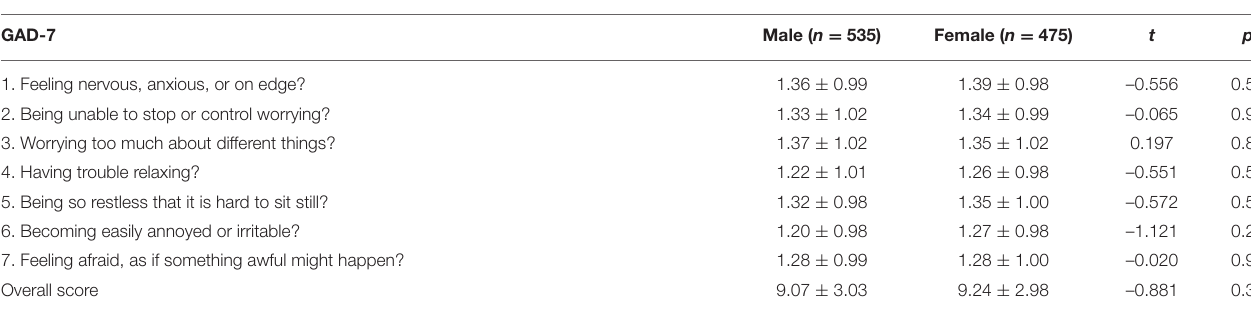
TABLE A2 | Gender difference in GAD-7 item scores ( ¯ x ± s ). GAD-7